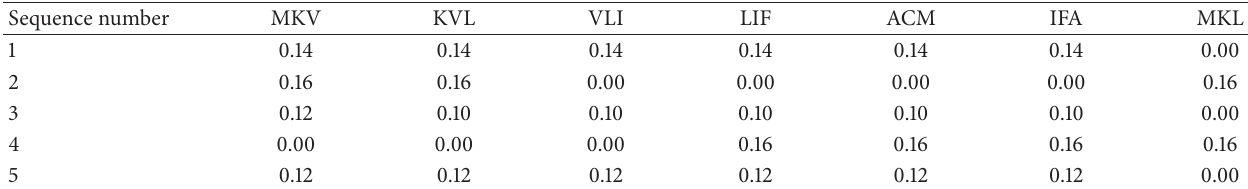
Table 3: The frequency of 𝑋 3 (three letter amino acids descriptors) for each sequence.